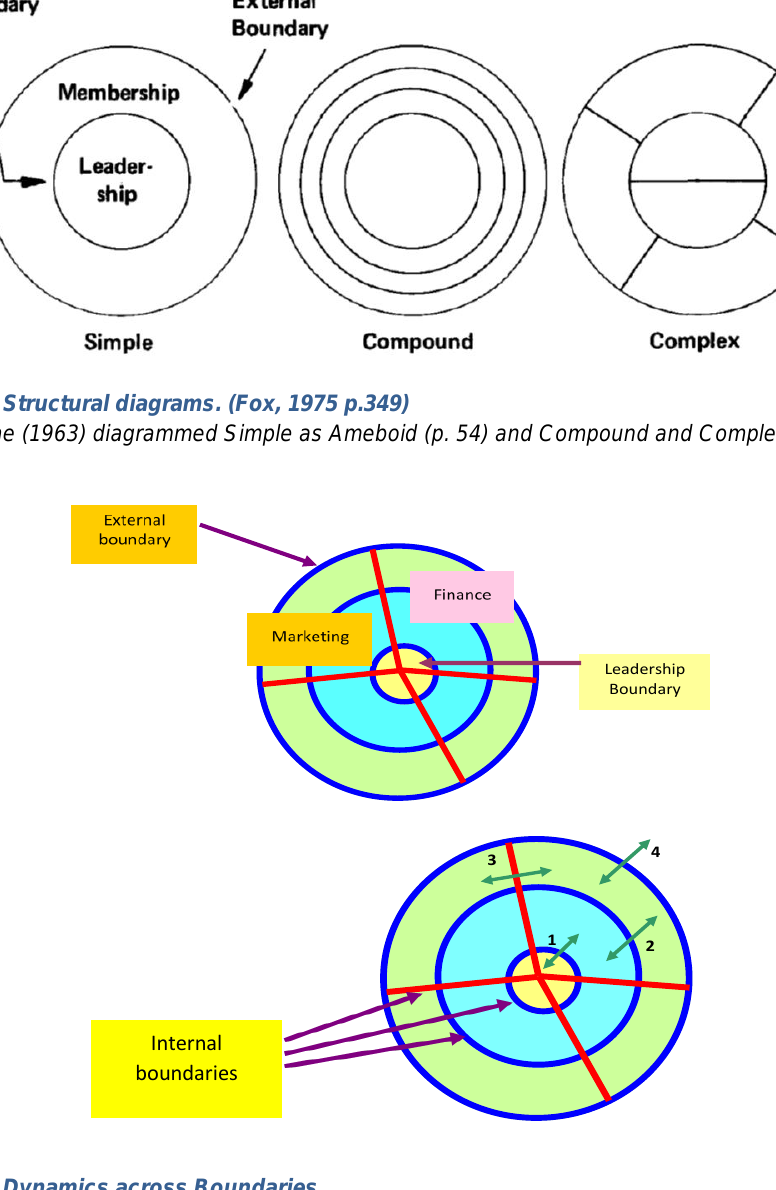
Figure 18: Dynamics across